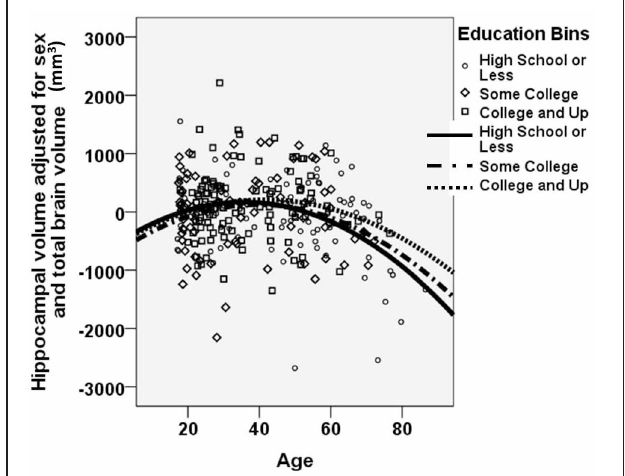
FIGURE 3 | A dose-dependent moderating effect of education on age-related decrease in hippocampal volume. A “dose-dependent” effect of education is observed. Age-related decline in hippocampal volume is most pronounced among the least educated individuals. In contrast, age-related reduction in hippocampal volume is mitigated among individuals with higher educational attainment. Hippocampal volume is portrayed as the unstandardized residual, after adjusting for sex and total brain volume. The figure excludes the 13 data points that represented “influential points” as identified using the standardized difference in beta. Note that all analyses were performed using continuous variables for age, years of educational attainment, and hippocampal volume. For clarity of presentation, educational attainment is represented graphically in bins, with high school or less portrayed with circles/solid line; some college portrayed with diamonds/dashed-dotted line; and college or beyond portrayed with squares/dotted